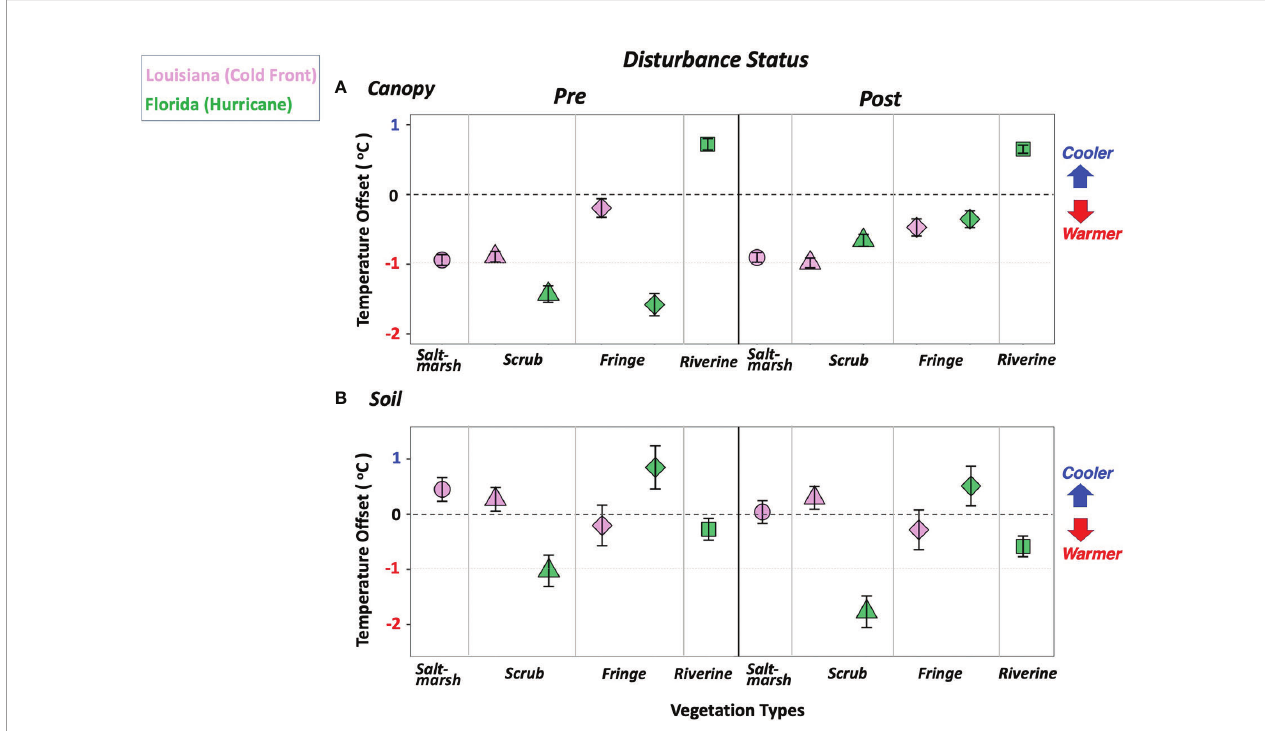
FIGURE 3 | Least square means ( ± 1 SE) of (A) canopy offset (the difference between free-air and canopy-air temperatures) and (B) soil offset (the difference between canopy-air and soil temperatures) in the period of pre- and post-disturbance (i.e., cold front in Louisiana sites and Hurricane Irma in Florida sites) across multiple vegetation types, including saltmarsh, scrub, fringe, and riverine mangroves in wetlands located in coastal Louisiana and South Florida, respectively. Positive offset indicates cooler conditions while negative offset represents warmer